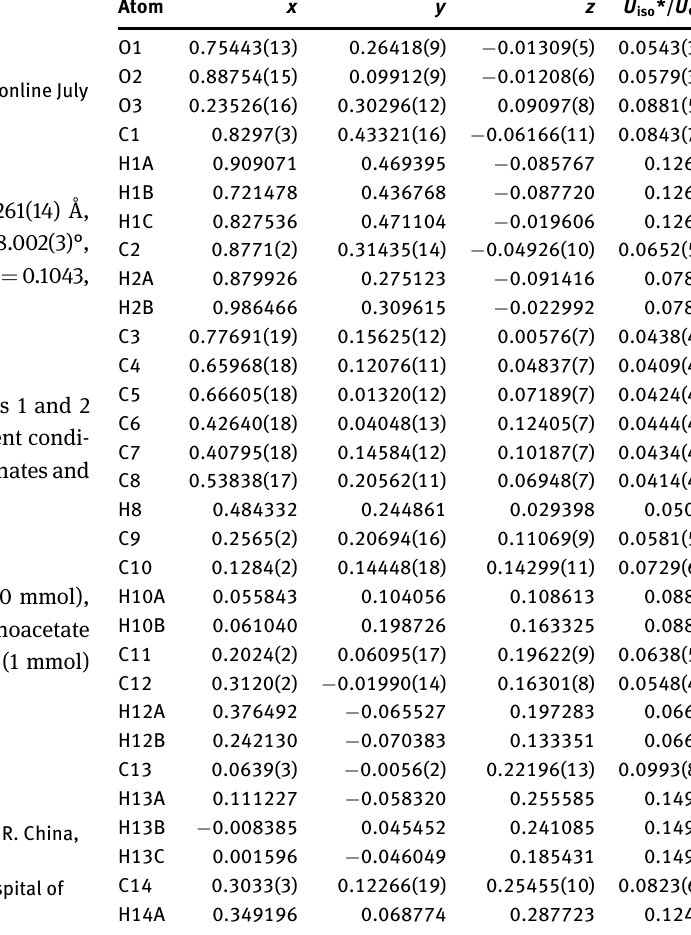
Table 2: Fractional atomic coordinates and isotropic or equivalent isotropic displacement parameters (Å 2